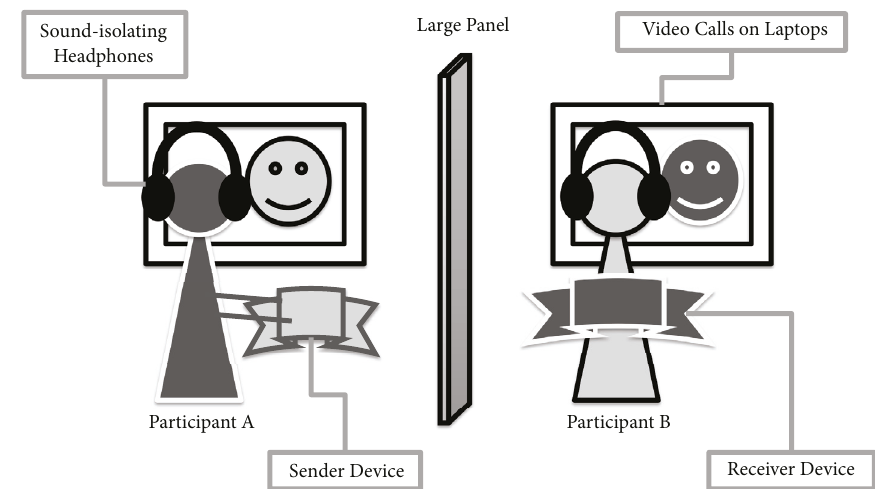
Figure 5: Schematic description of the experimental setting.